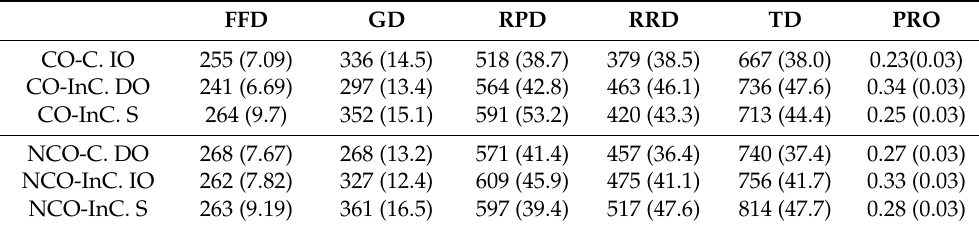
Table 2. Mean Values for the Six Conditions (in milliseconds (msec.) for durations), with Standard Errors in Parentheses, for the Six Eye-tracking Measures for the Immediately Preverbal Region. Here, and in all the following tables: CO = Canonical Word-Order, NCO = Non-canonical Word-Order, F = Focus, C = Congruous, InC = Incongruous, IO = Indirect Object, DO = Direct Object, and S = Subject. FFD GD RPD RRD